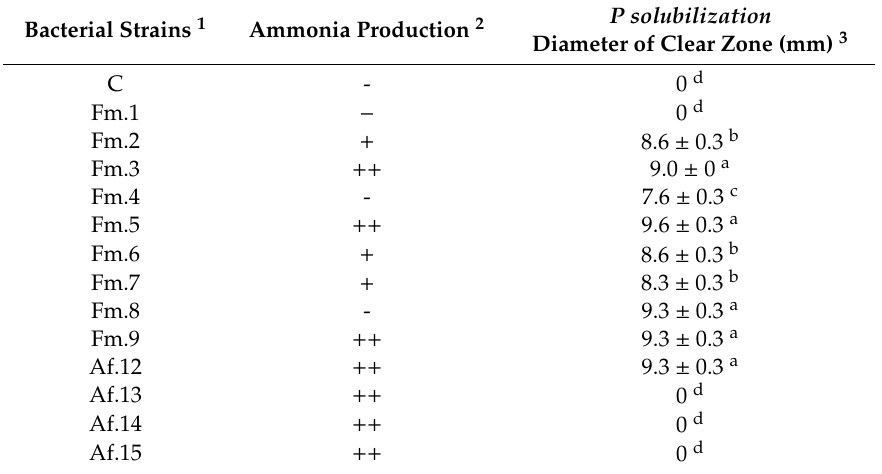
Table 5. Ammonia production and phosphate solubilization of endophytic bacterial strains.